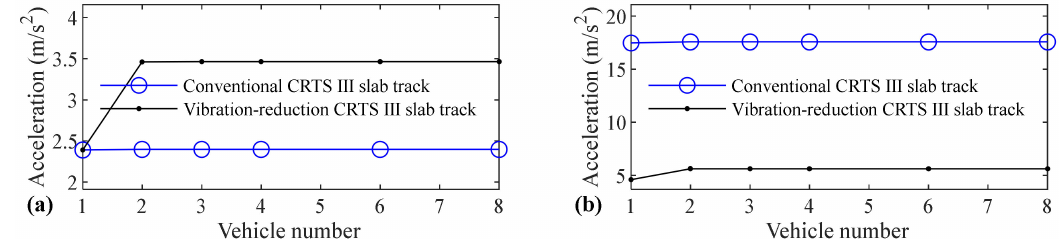
Figure 8. Relation between vehicle number and acceleration of concrete base: ( a ) without and ( b ) with random track irregularity.